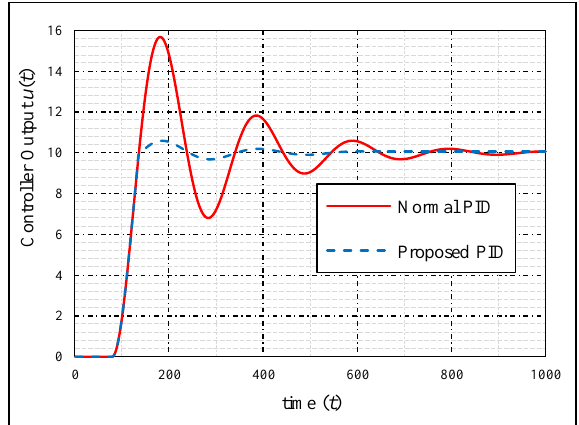
Figure. 2. Comparative analysis of PID Controllers